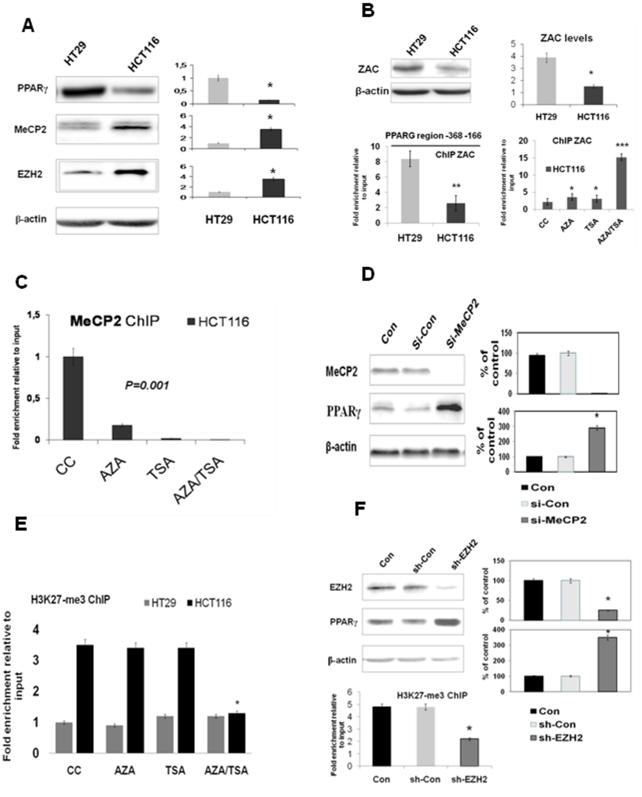
MeCP2 and EZH2 are negative regulators of PPARG expression in CRC cell lines.(A) Western-blot analysis shows higher levels of MeCP2 and EZH2 in HCT116 than HT29 cells *P<0.01. (B) In contrast, ZAC is more expressed in HT29 than HCT116 cells, thus directly correlating with PPARγ levels. ChIP assays performed in basal conditions show a ZAC enrichment in HT29 cells. In HCT116, ZAC is highly recruited at the PPARG promoter after epigenetic treatments correlating with PPARG transcription recovery *P<0.05; **P = 0.004; ***P = 0.0001. (C) qChIP analysis shows enrichment of MeCP2 at the PPARG promoter that is lost after pharmacological treatments. (D) A specific MeCP2-siRNA transfected into HCT116 cells determines complete silencing of its own gene and PPARγ re-expression, as assessed by Western blot, relatively to controls *P = 0.01. (E) qChIP analysis shows that trimethylated H3K27 is enriched in HCT116 as compared to HT29 cells. After AZA/TSA addition, H3K27 is unchanged in HT29 and reduced in HCT116 cells *P<0.05. (F) A specific EZH2-shRNA introduced in HCT116 efficiently silences its own gene and induces PPARγ expression, as illustrated by Western-blot analysis. This coincides with reduced H3K27me3 levels analyzed by qChIP. *P<0.05. The time-points for co-treatments were 72 hs for 5 µM AZA and 24 hs for 300 nM TSA, alone or in combination; CC indicates untreated control cells. Error bars indicate the standard deviation of the mean.